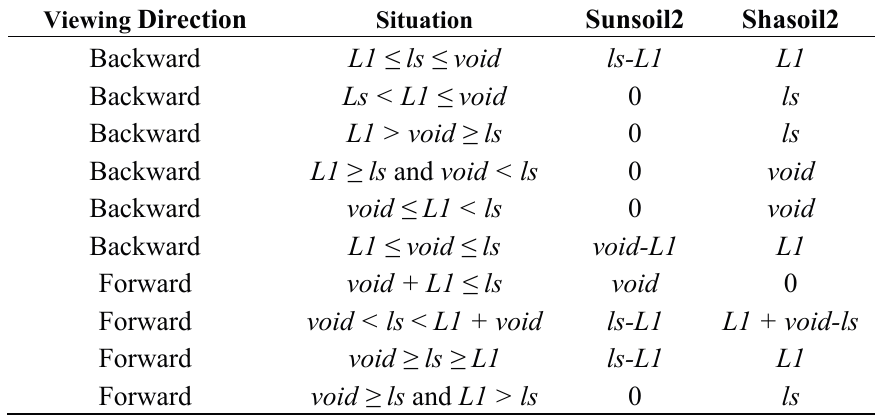
Table 4. The relative horizontal projected length for the second category illuminated and shadowed background in backward-scatter and forward-scatter situations.